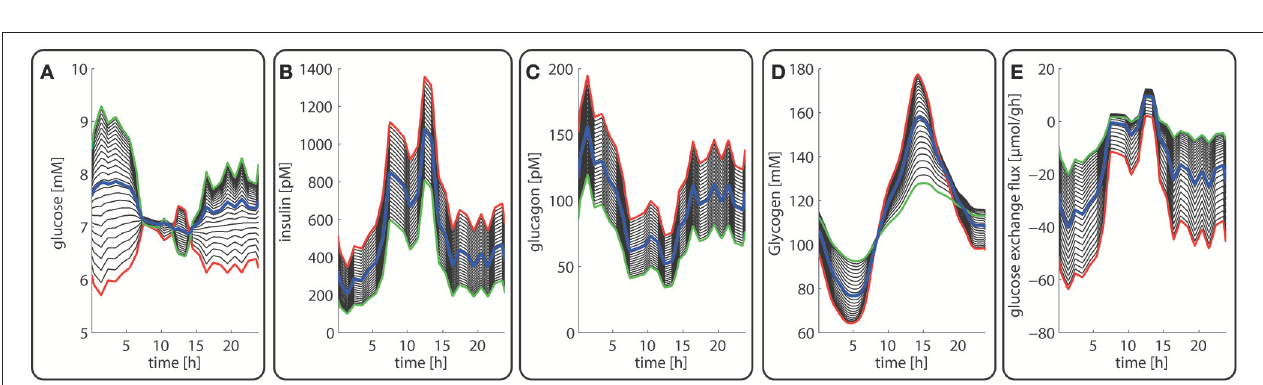
FIGURE 3 | Diurnal variations in the plasma levels of glucose (A) , insulin (B) , glucagon (C) , cellular glycogen (D) and the glucose exchange flux (E) in different zones along the porto-central axis. The different curves refer to different spatial positions of hepatocytes, counted from periportal (red curve) to percentral (green curve). The bold blue line refers to the means values of the shown variable. Note that the red curves ( = most portal cell) for the hormones and glucose are identical with their plasma profiles.